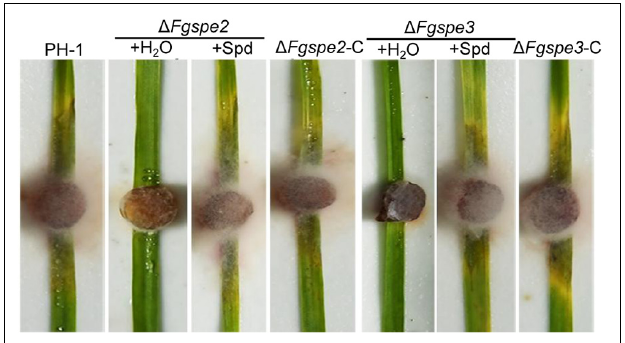
FIGURE 7 | Exogenous addition of spermidine restores virulence of (cid:49) Fgspe2 and (cid:49) Fgspe3 mutants in plant. Disease symptom on wheat seedling leaves inoculated with the (cid:49) Fgspe2 and (cid:49) Fgspe3 mutants which are treated with or without Spd at the final concentration of 5